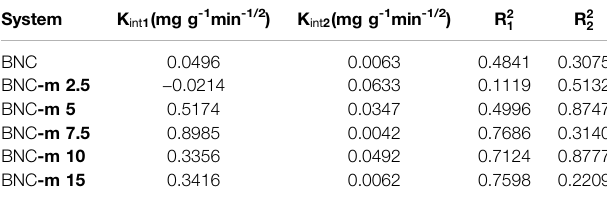
TABLE 7 | Kinetic parameters for the intraparticle diffusion